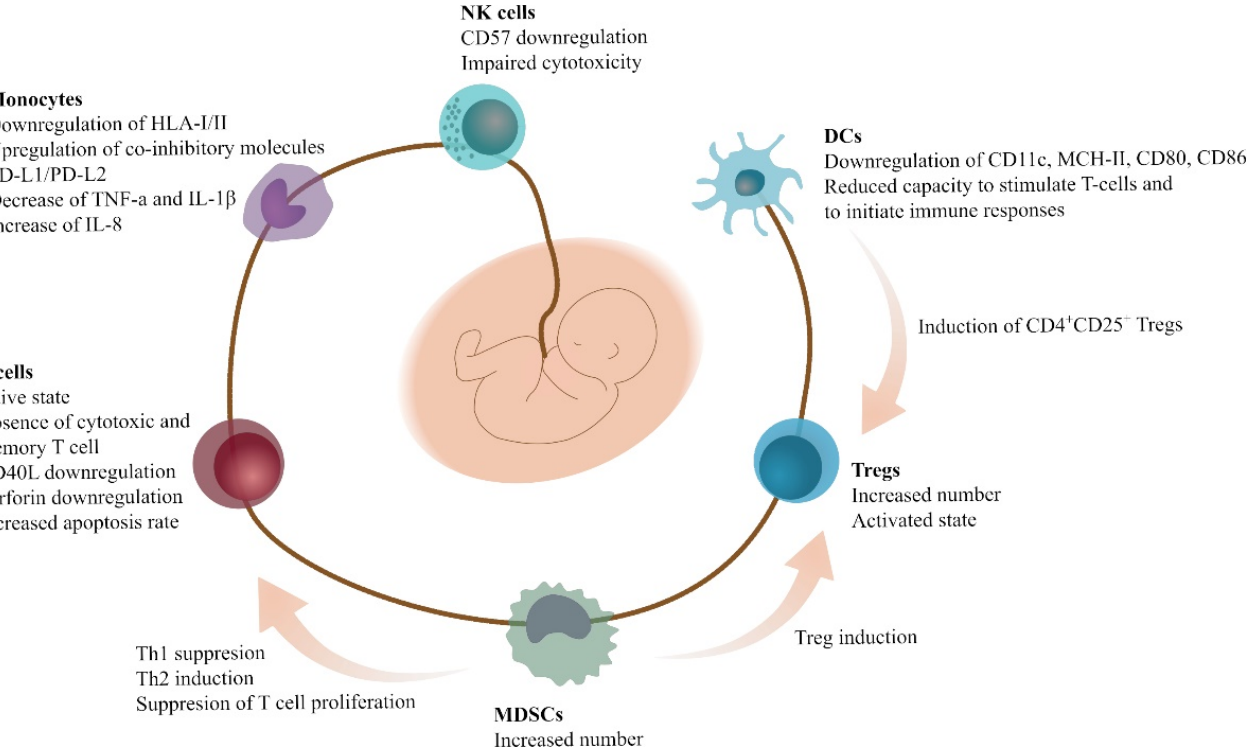
Figure 1. Specific characteristics and interactions of different immune cells in the UCB. Immune cells found in the UCB exhibit distinct features, leading to complex immune regulation patterns.